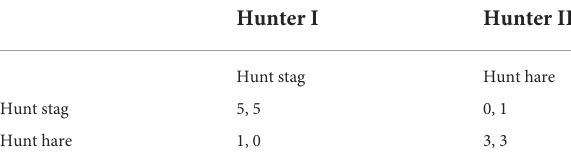
TABLE 1 Stag hunt or assurance game payoff